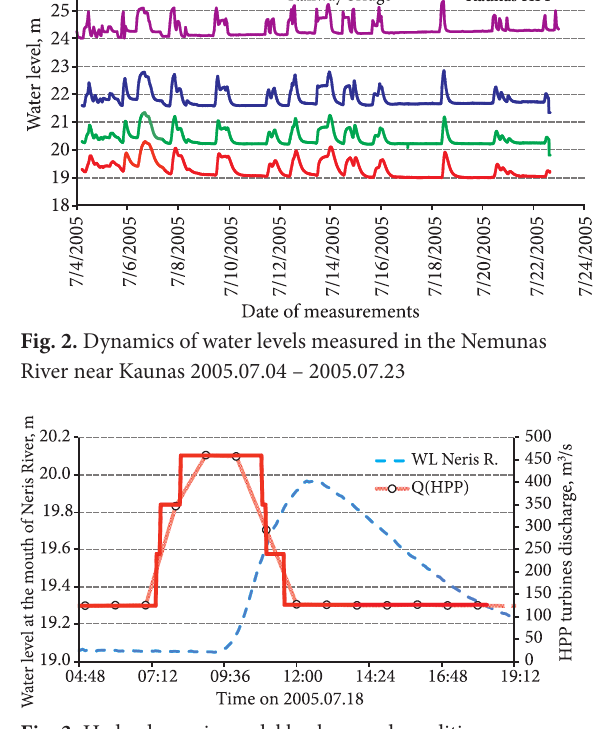
Fig. 3. Hydrodynamic model background